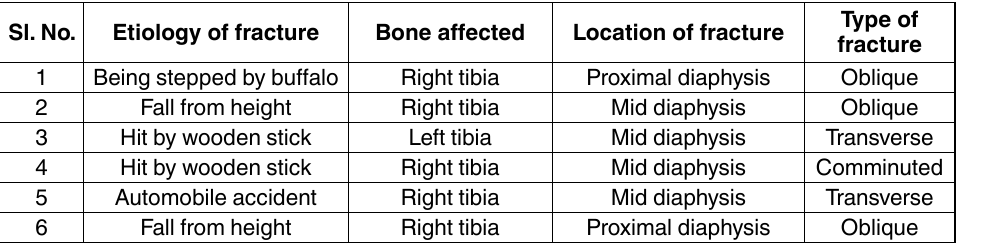
table 3. Etiology of fracture, bone affected, location of the fracture and the type of fracture in Dogs sl.